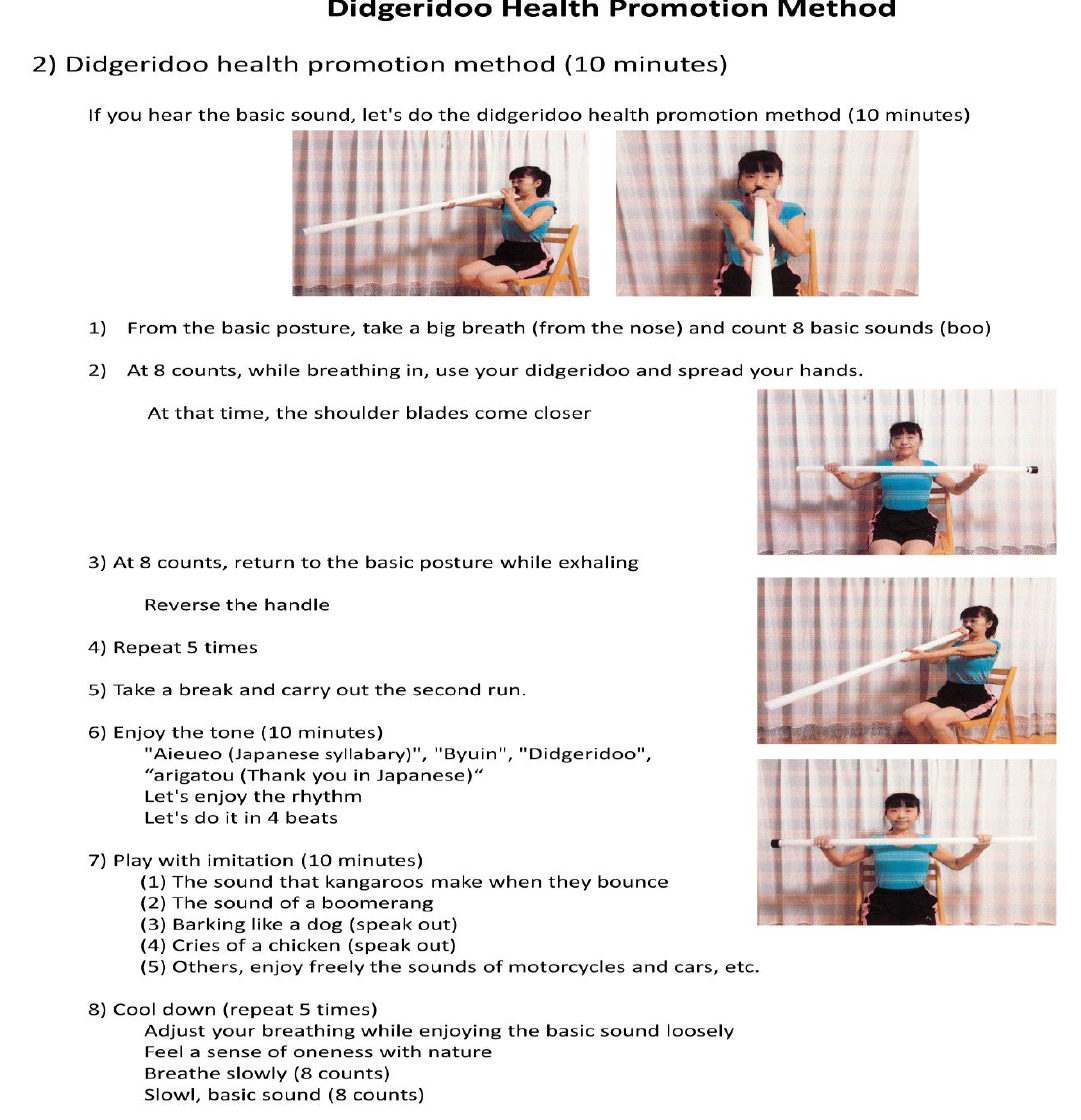
Figure 3. DHPM. After the preparatory movement, use of a plastic tube to imitate the didgeridoo to actually blow and make a sound and practice the health promotion method. An execution of a lesson.